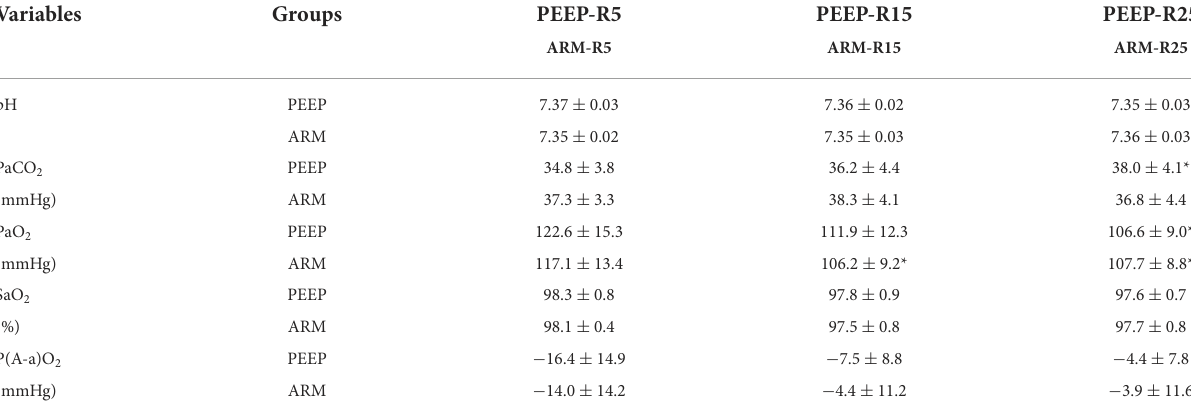
TABLE 2 Blood gas measurements during 5–25min of recovery from isoflurane-anesthetized dogs mechanically ventilated with tidal volume of 8mL kg − 1 submitted to recruitment maneuver (ARM group, n = 11 ) or without recruitment maneuver (PEEP group, n = 10 ) and use of 5 cmH 2 O of positive end-expiratory pressure